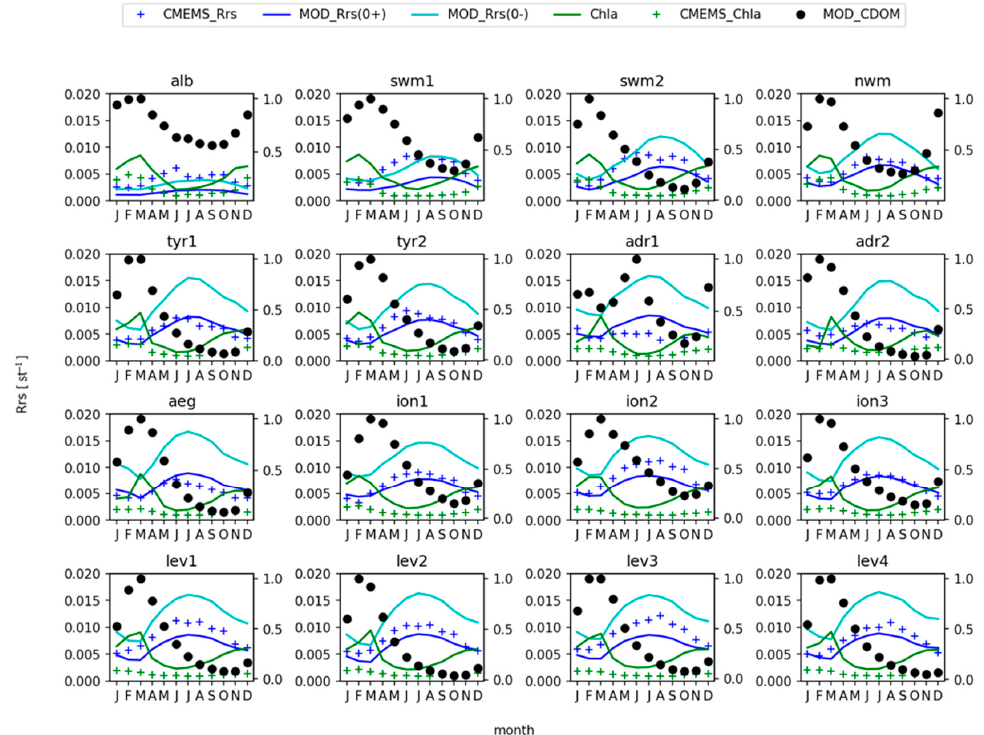
Figure 8. Same as Figure 7 but for EXP-2.